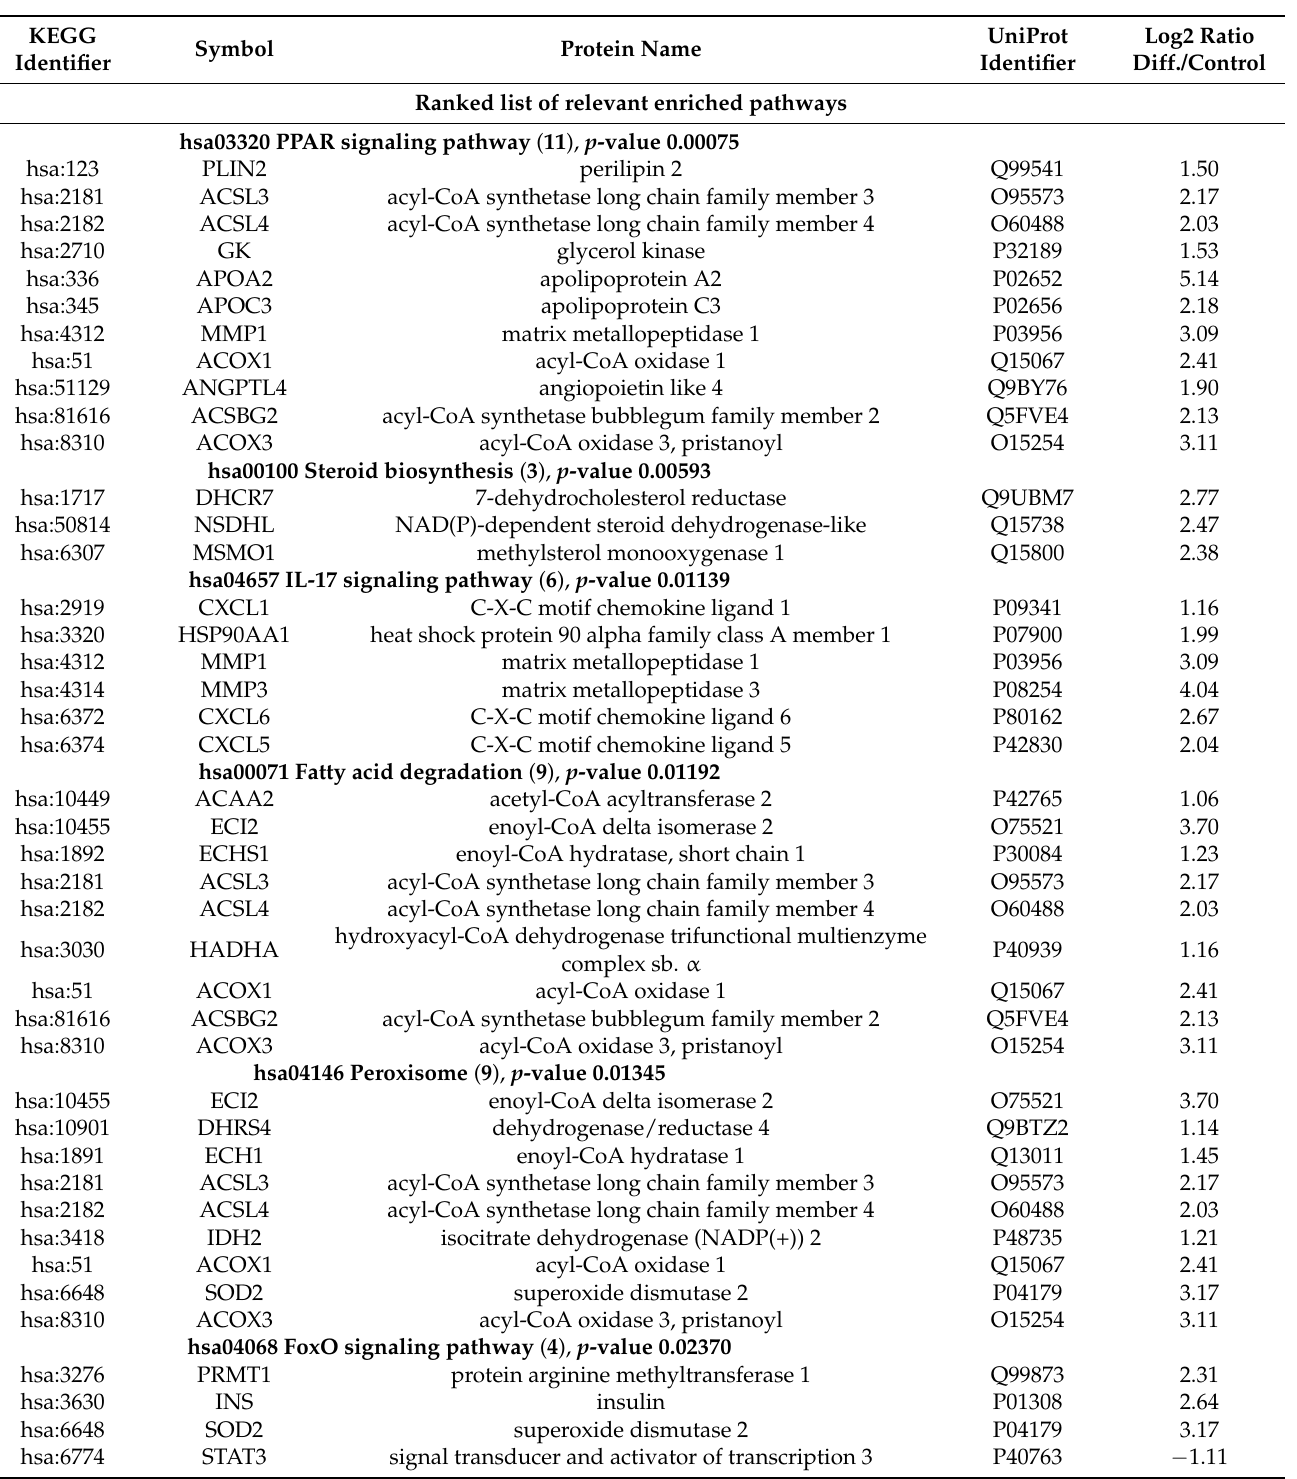
Table 1. List of proteins belonging to KEGG pathways discussed in the text and visualized in Figure